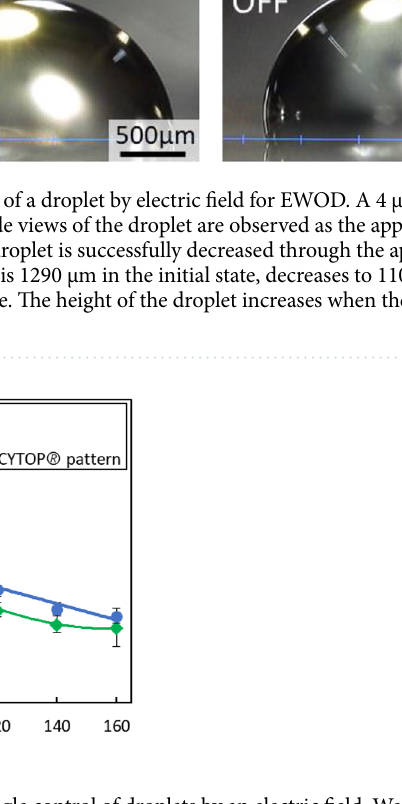
Figure 6. Material dependence of the contact angle control of droplets by an electric field. We form 4 μl droplet with an initial height of 1293 µm on a circular pattern with electrodes. A voltage is applied between the center and outer electrodes for electric field generation. The droplet changes shape, and the droplet height decreases. The contact angles of the droplet for an applied voltage of 0–160 V are measured. The contact angle decreases with increasing voltage. The phenomena on uniform surfaces of parylene C and Cytop ® are compared with the circular pattern composed of O 2 -plasma-treated parylene C and Cytop ® . The contact angles on all surfaces decrease when a voltage is applied. In the initial state without voltage for EWOD, the hydrophobic Cytop ® surface shows a higher contact angle than parylene C, whereas the circular pattern composed of O 2 -plasma- treated parylene C shows an intermediate angle between the others. The contact angles of Cytop ® and that in the circular pattern are similar at high